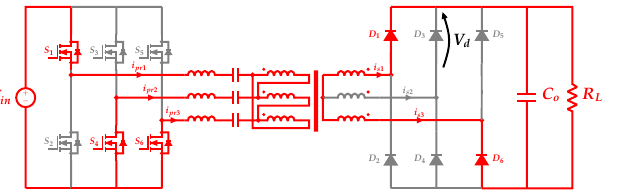
Figure 9. Circuit conditions in DCM1 mode during the interval t 1 + T sw /3 < t < T sw /3.